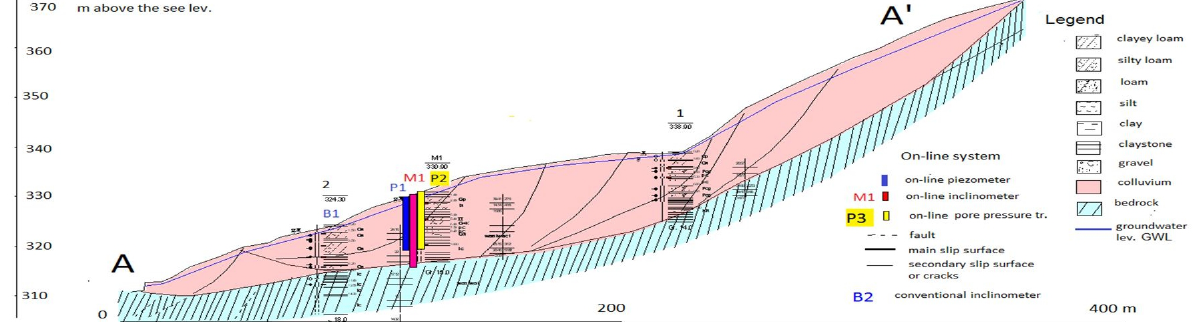
Figure 2. Geological engineering cross-section of landslide in Szymbark.